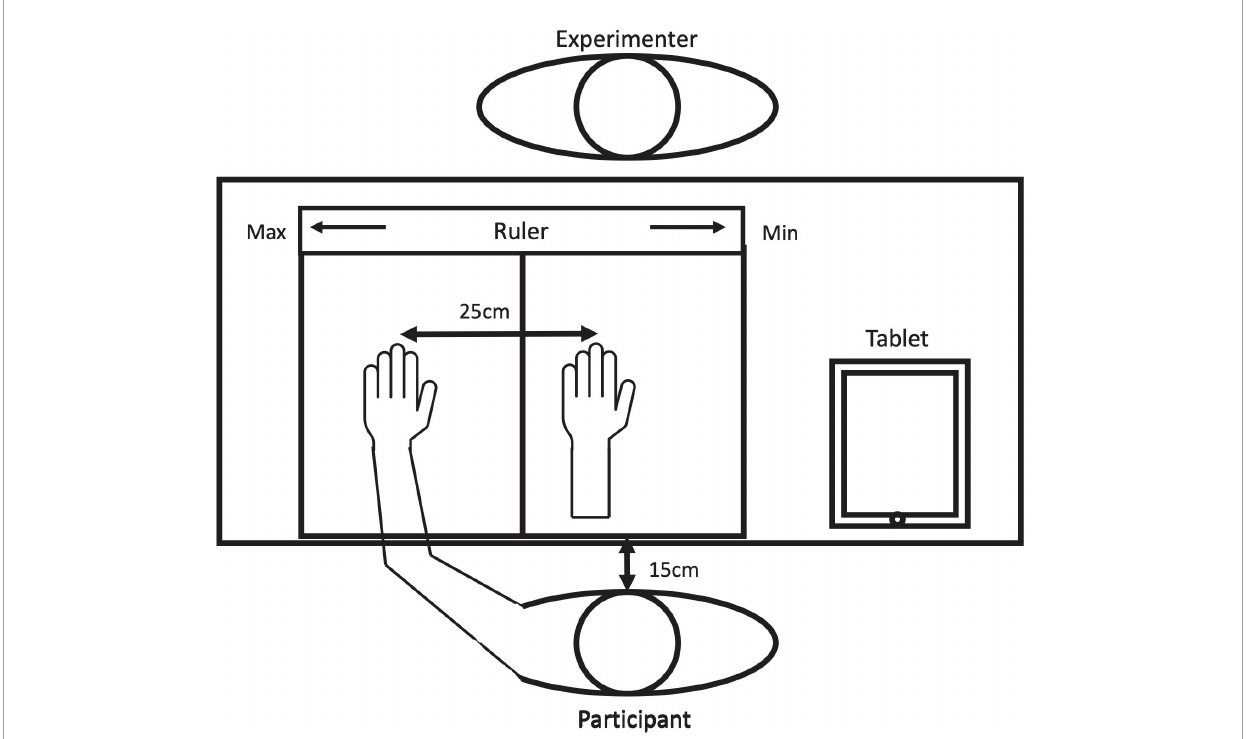
FIGURE1 Schematic illustration of the experimental setup. The ruler was attached to the experimenter’s side of the box, with its scale larger toward the right from the experimenter.